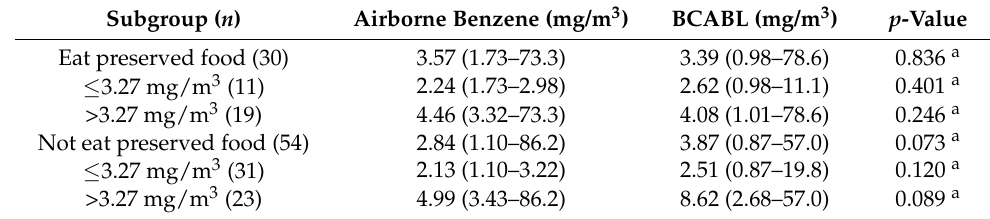
Table 5. Summary of airborne benzene and BCABL based on t, t -MA considering dietary